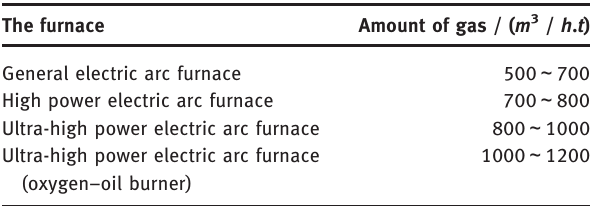
Table 1: The amount of gas in different electric arc furnace. The furnace Amount of gas / ( m  / h . t )